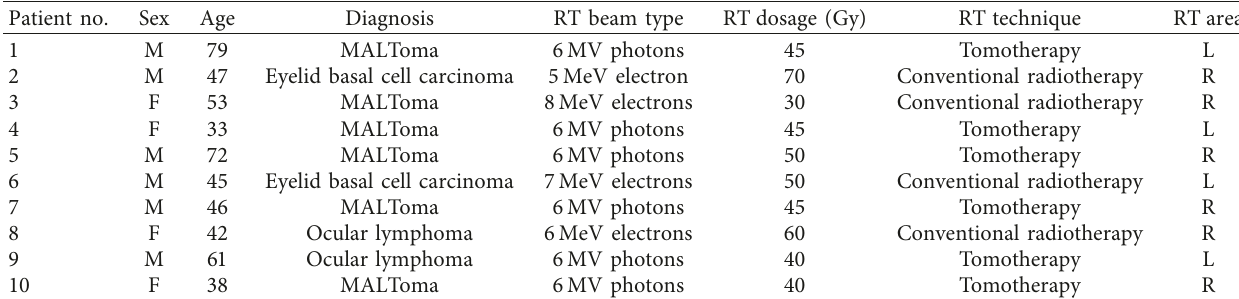
Table 1: Radiotherapy details of patients undergoing RT.